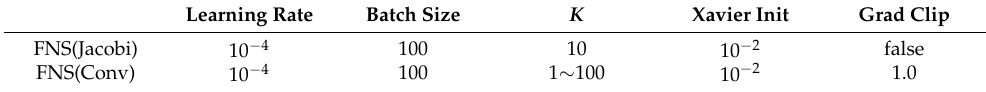
Table A3. Training hyperparameters for convection–diffusion equation.